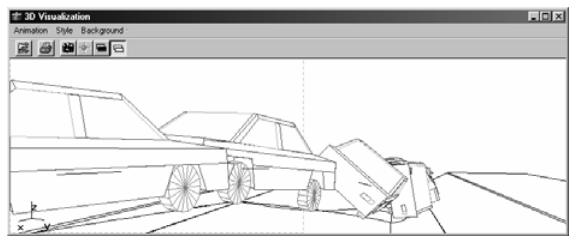
Fig 6. The view of overturning of the automobile in the space – from the back